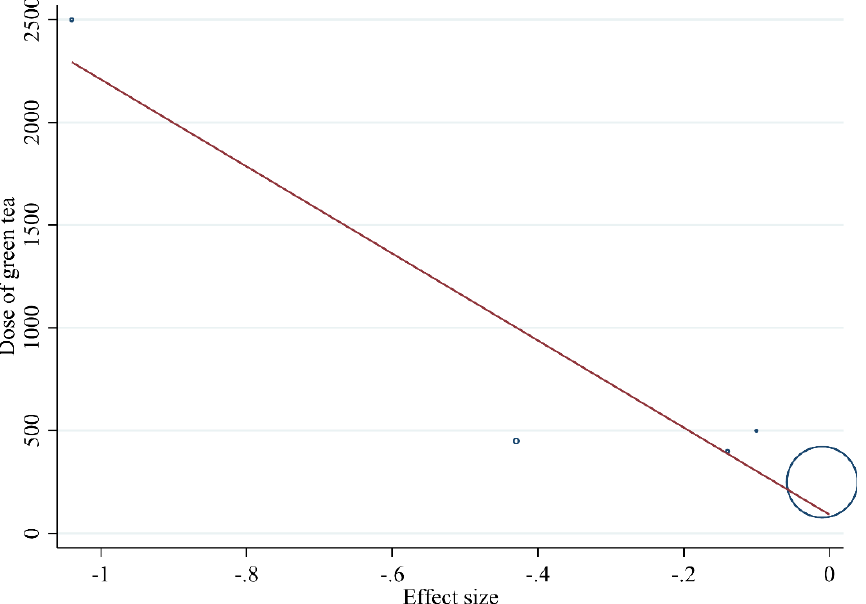
Figure 6. Random-effects meta-regression plot of the association between dose of green tea (mg/day) and MDA effect size.